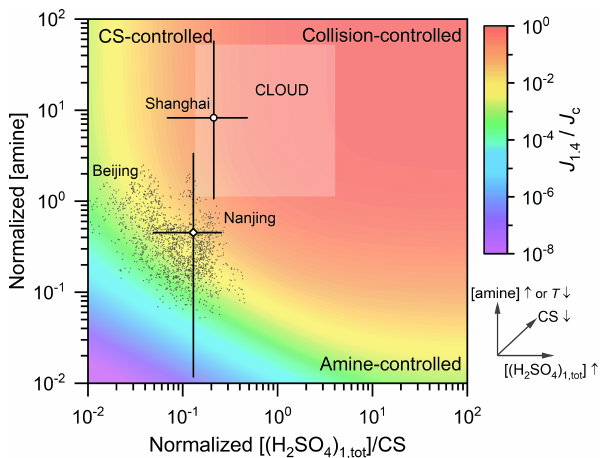
Figure 4. An illustrative figure for the governing factors of H 2 SO 4 – amine nucleation in various conditions. The horizontal and vertical coordinates are the normalized H 2 SO 4 and effective amine concen- trations, respectively, and the normalizing formulae are given in the main text. The dependencies of horizontal and vertical coordinates or [(H 2 SO 4 ) 1 , tot ], CS, [amine], and temperature ( T ) are indicated by the arrows. The color indicates the normalized steady-state for- mation rate of simulated 1.4nm particles, J 1 . 4 . Then J c is the the- oretical formation rate at the collision limit. The dark grey mark- ers are the measured data on NPF days in Beijing with a tempo- ral resolution of 5min. The semitransparent square above the col- ored contour is the estimated range for experimental conditions of the CLOUD studies (Almeida et al., 2013; Kürten et al., 2014): [(H 2 SO 4 ) 1 , tot ] between 5 × 10 5 and 1 . 5 × 10 7 cm − 3 , [amine] be- tween 3 and 140ppt, T = 278K, and the sum of wall loss and dilu- tion rates (instead of CS) was estimated to be 0.002s − 1 . The open markers and error bars indicate the median values and approximate ranges, respectively, of the normalized H 2 SO 4 and effective amine concentrations in Shanghai and Nanjing. The Shanghai data were reported by Yao et al. (2016, 2018). The Nanjing data were reported by Zheng et al. (2015) and Deng et al. (2020b). Note that for Shang- hai and Nanjing, the amine concentrations were measured in differ- ent campaigns from those for H 2 SO 4 and CS, and the amine con- centrations are the average of all days rather than the new particle formation period only. As a result, there are potential uncertainties in the results for Shanghai and